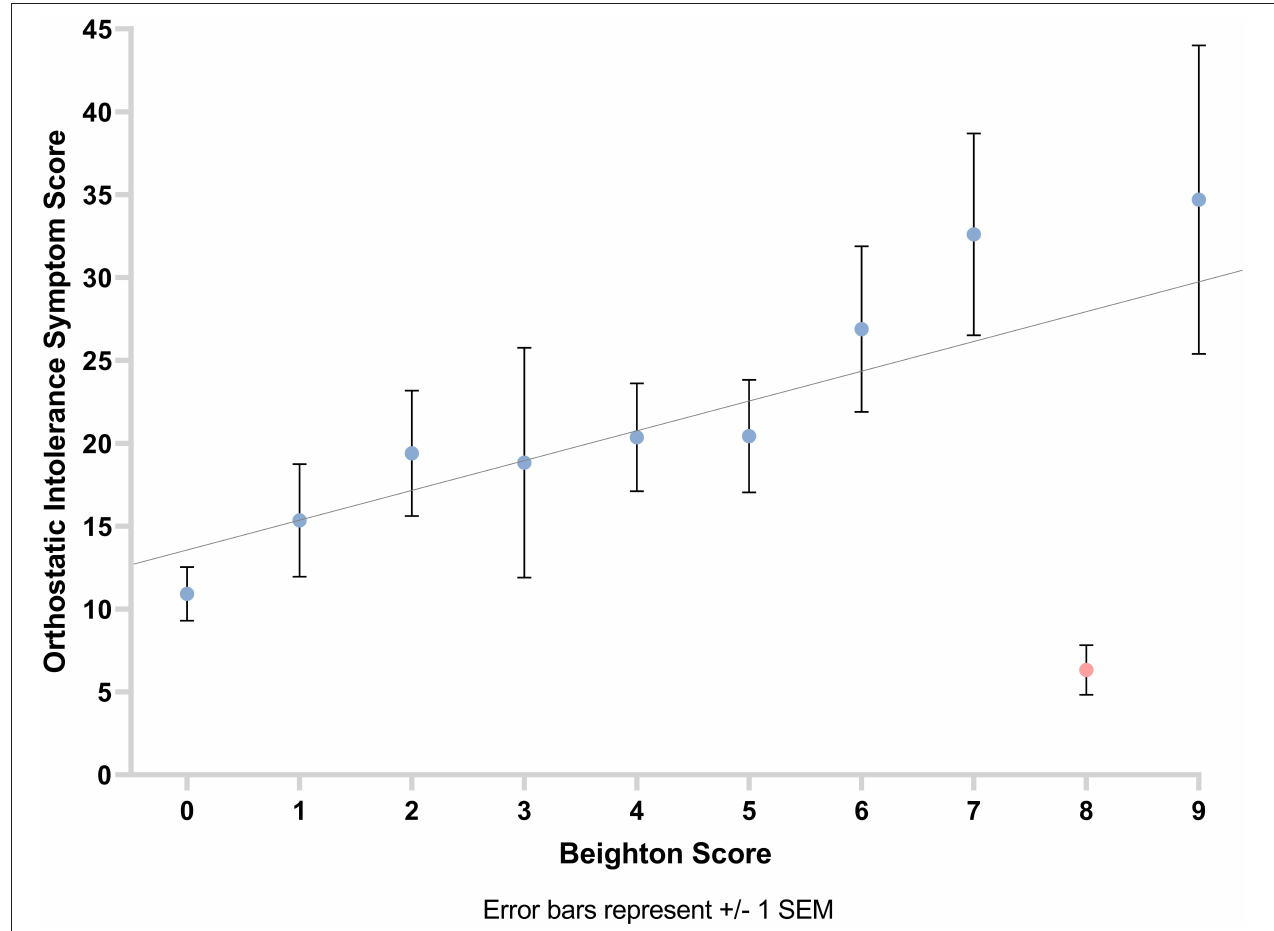
FIGURE 4 | Graph showing the relationship between orthostatic intolerance symptom score and Beighton score with line of best fit. Error bars show ± 1 standard error of the